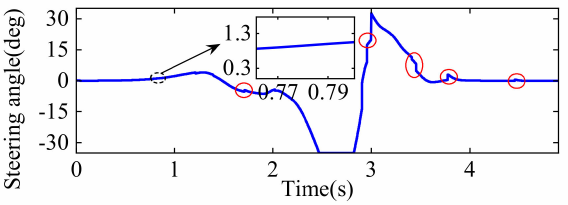
Figure 27. Response of the steering angle under the velocity of 25